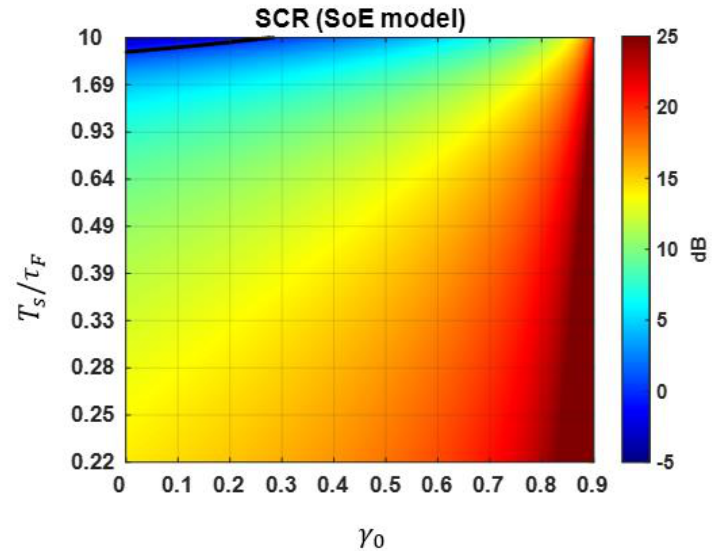
Figure 12. Signal-to-Clutter Ratio (SCR) achieved by focusing a target decorrelating according to SoE model, for di ff erent values of γ 0 (horizontal axis) and of the integration time normalized by the fast decay time (vertical axis). The long-term decay has been fixed to τ = 2 days. The black line marks the combinations for which SCR is 0 dB.